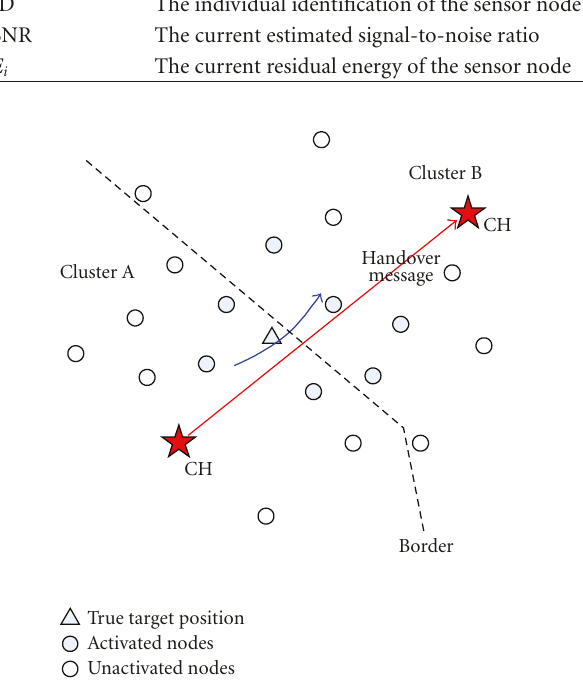
Figure 2: Illustration of target tracking task handover between